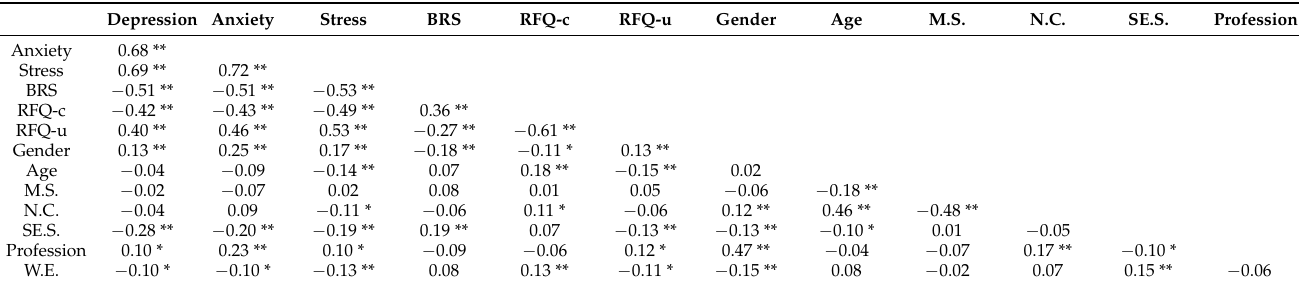
Table 3. Correlations between the investigated variables.